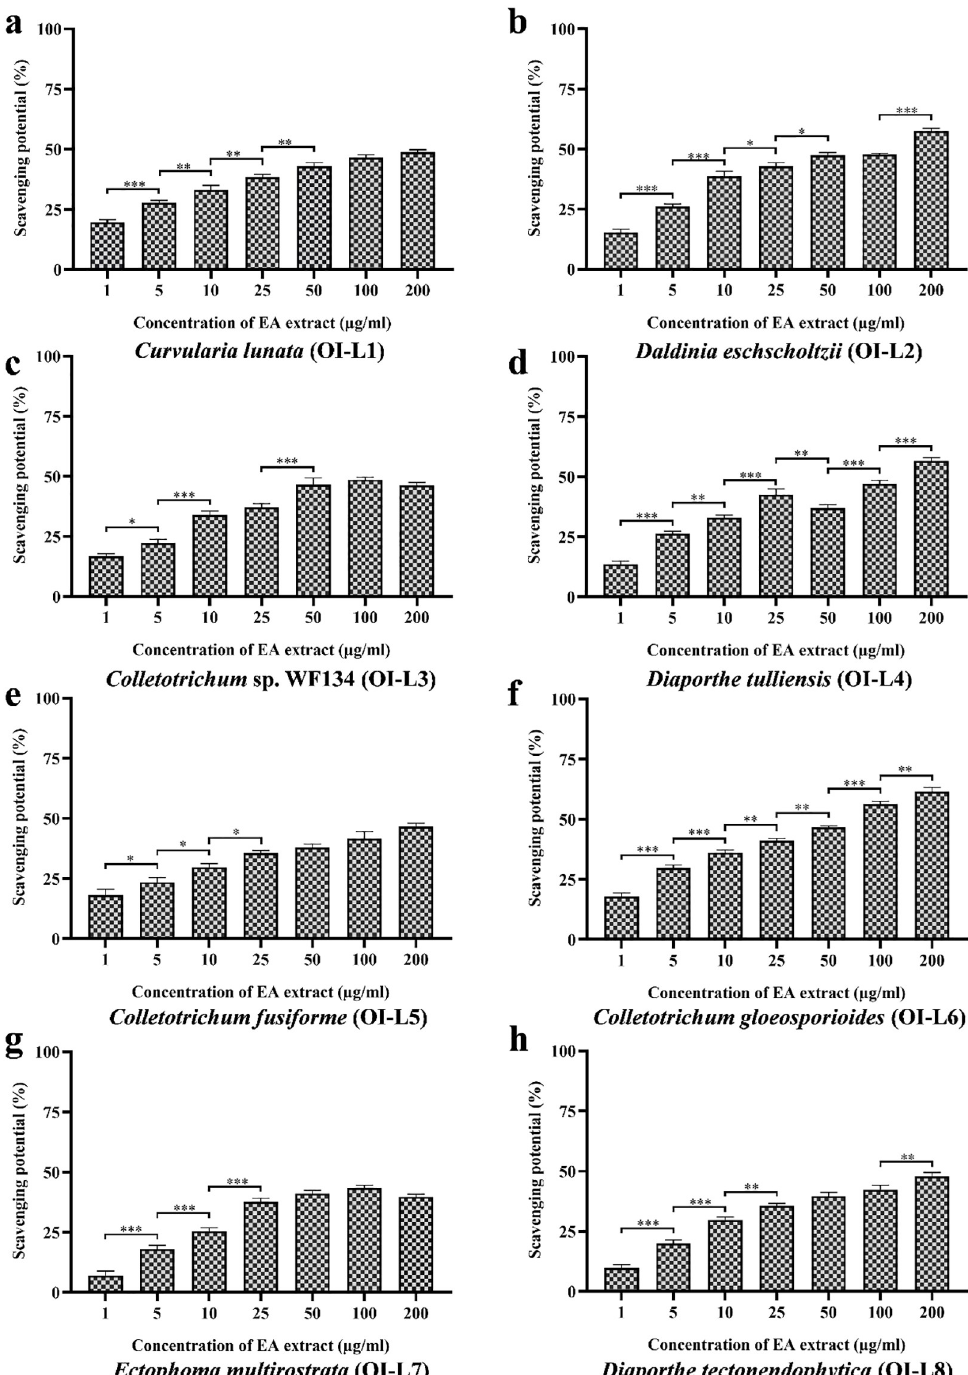
Fig 5. Superoxide anion scavenging potential of EA extract of fungal endophytes (a) C . lunata , (b) D . eschscholtzii , (c) Colletotrichum sp. WF134, (d) D . tulliensis , (e) C . fusiforme , (f) C . gloeosporioides , (g) E . multirostrata and (h) D . tectonendophytica . All experiments were performed in triplicate. P-value was calculated by comparing means ± SD of the superoxide radical scavenging potential (%), using one-way ANOVA followed by Tukey to determine statistical significance. Statistical significance are as follows; ��� , P � 0.001; �� , P � 0.002; � , P � 0.033.